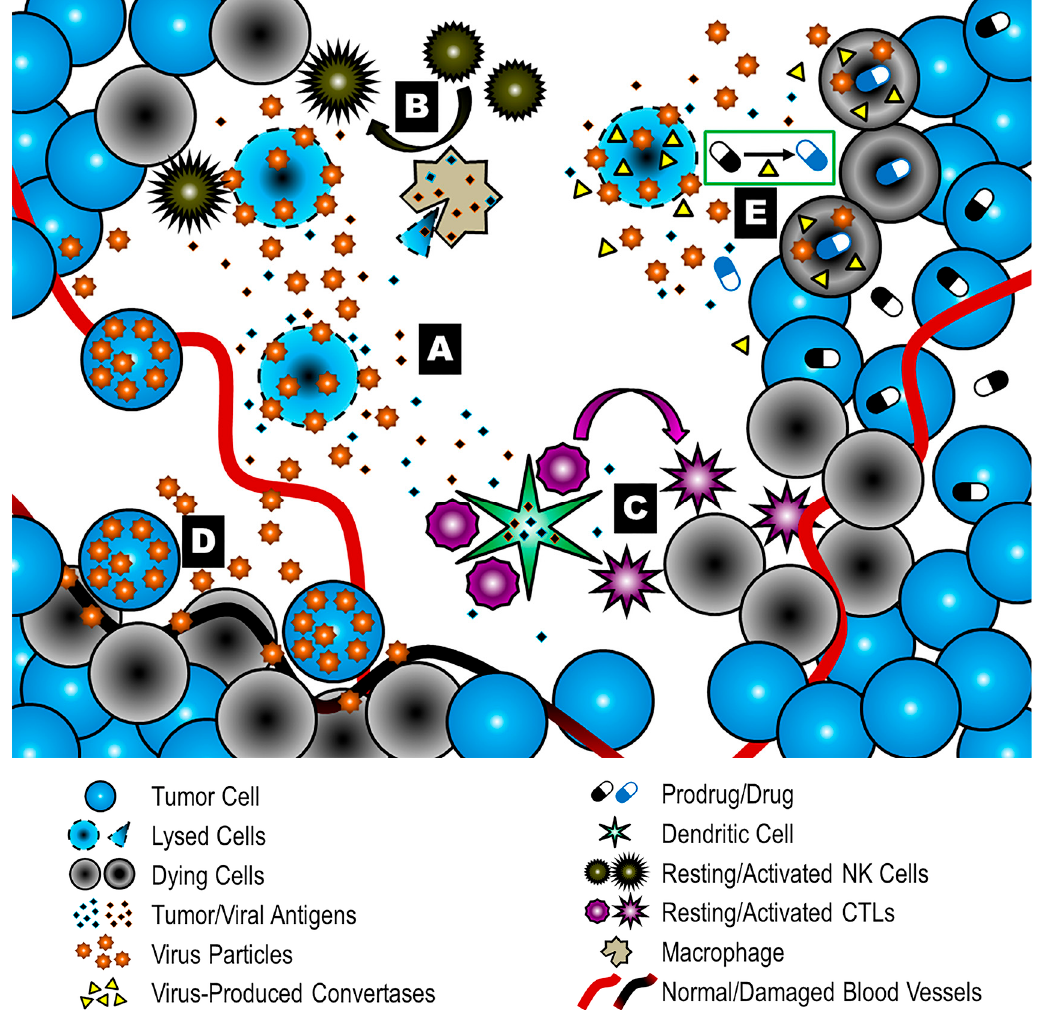
Figure 3. Multi-mechanistic modes of action of oncolytic virotherapy. Direct lytic replication ( A ) can be supported by additional antitumor processes in the context of oncolysis, e.g., immunogenic cell death and subsequent innate ( B ) and adaptive ( C ) antitumor immune responses, and endothelial targeting ( D ). This complexity can be exploited and expanded by genetic modifications and combination therapies. One approach is encoding prodrug convertases in the viral genome, which mediate local activation of systemically applied prodrugs ( E ). CTLs: Cytotoxic T lymphocytes; NK: Natural killer.